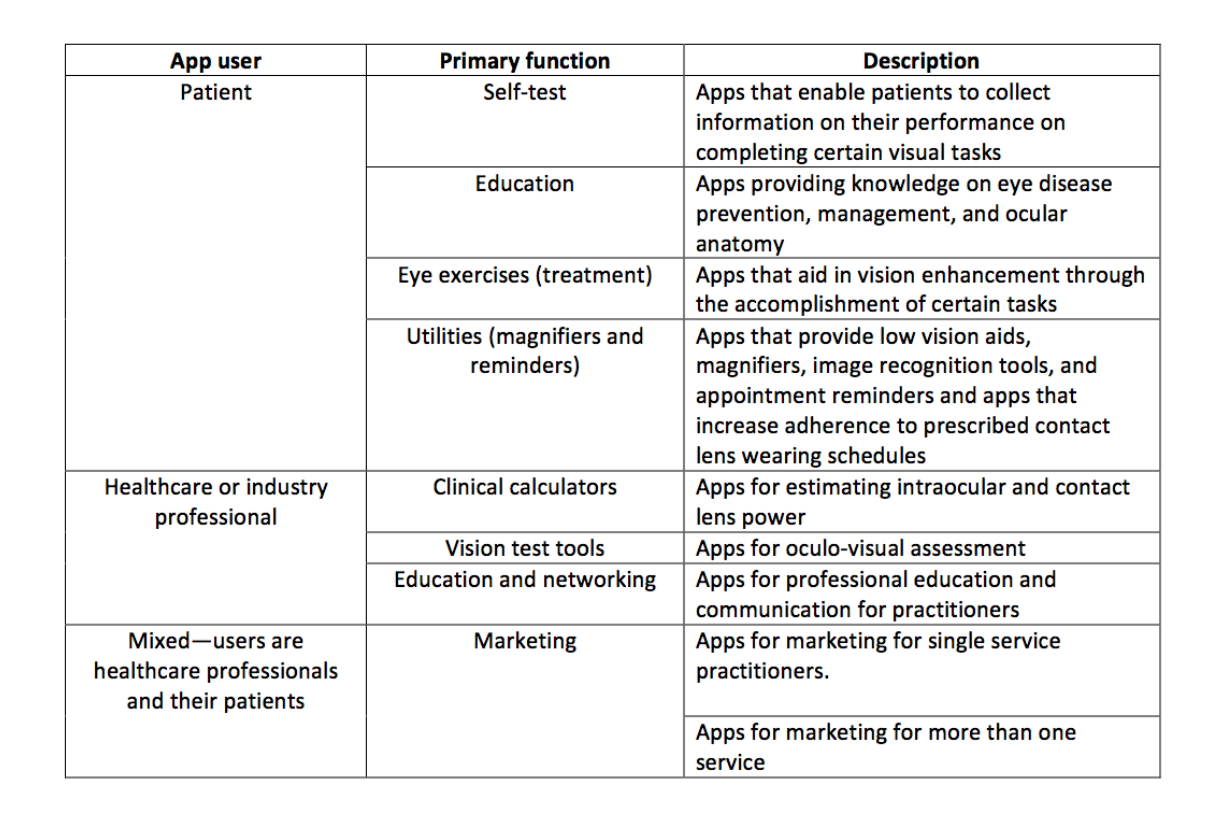
Figure 2. A classification of eye-care apps in the Canadian iTunes